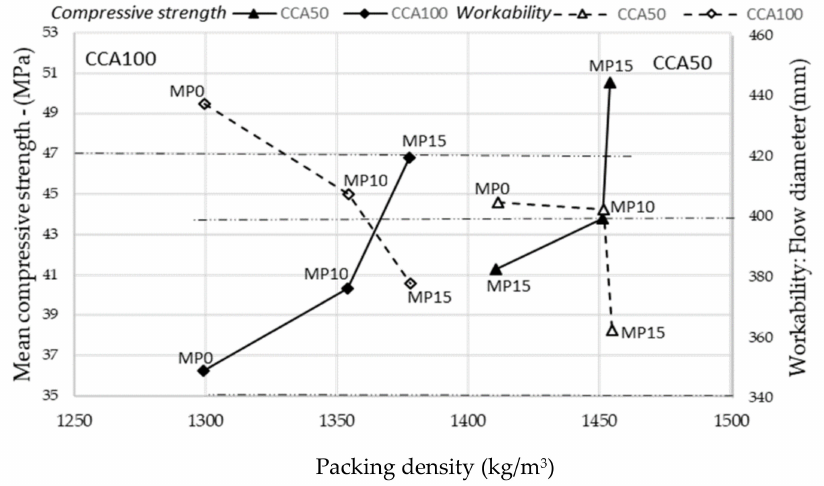
Figure 7. Packing density of aggregate related to compressive strength and workability; Reference compressive strength: 47 MPa; Reference workability: Class F2 (340–400